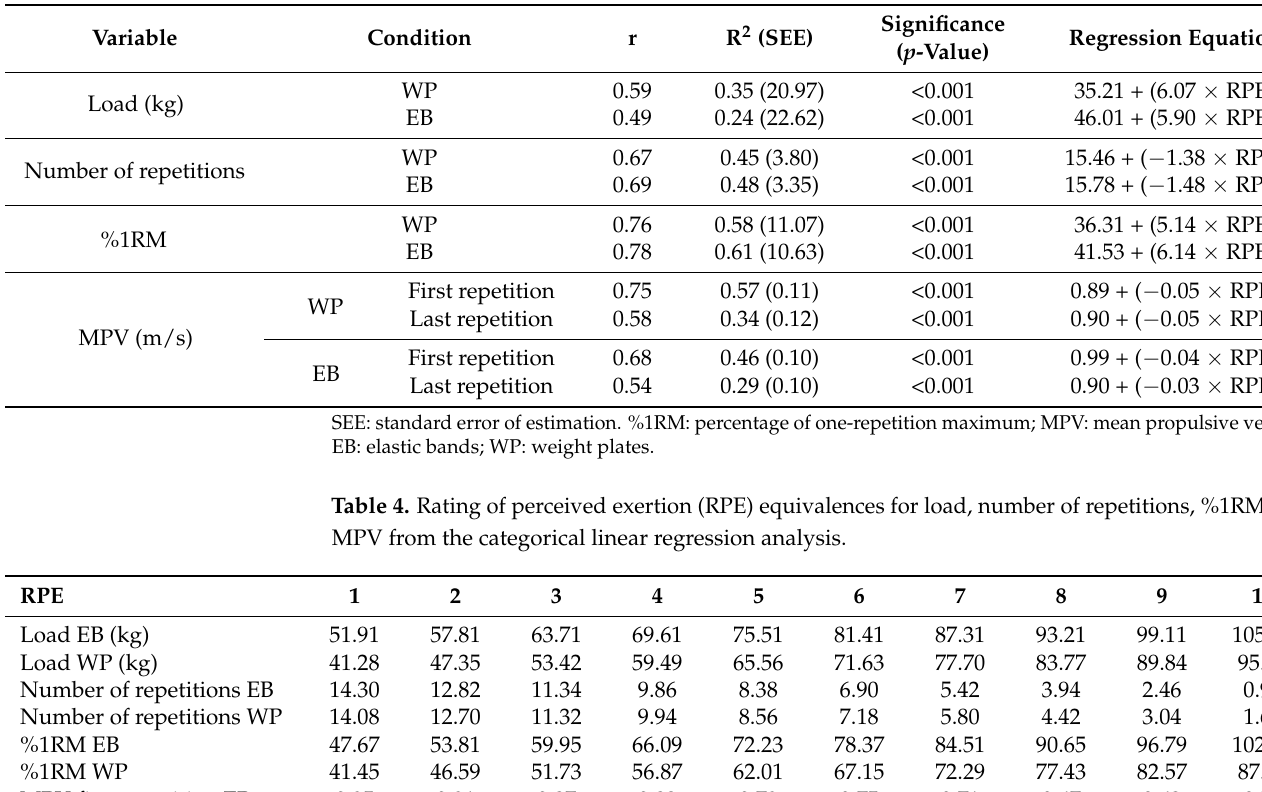
Table 3. Prediction of load, number of repetitions, %1RM, and MPV values from the first repetition rating of perceived exertion score (linear regression).